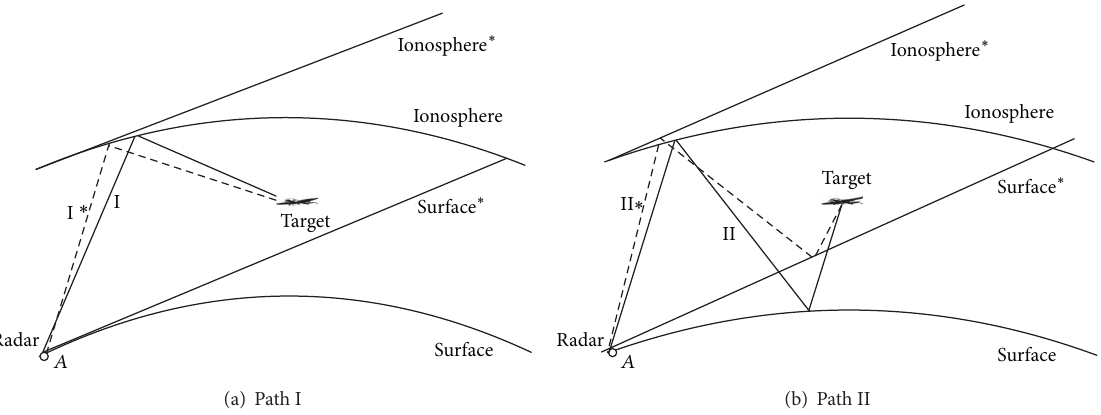
Figure 12: The Path I and Path II in two kinds of